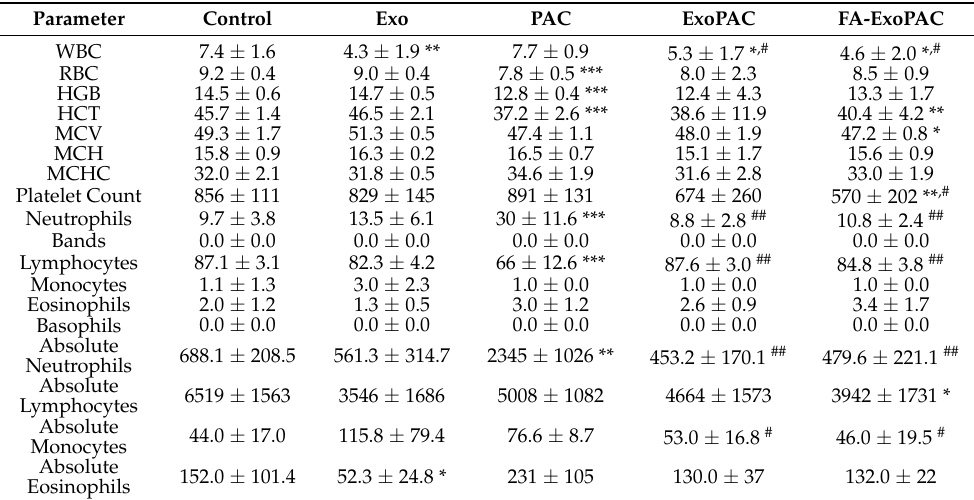
Table 2. Effect on hematological parameters (systemic toxicity) following 28-day exposure to exo- somes, PAC and ExoPAC in C57BL/6